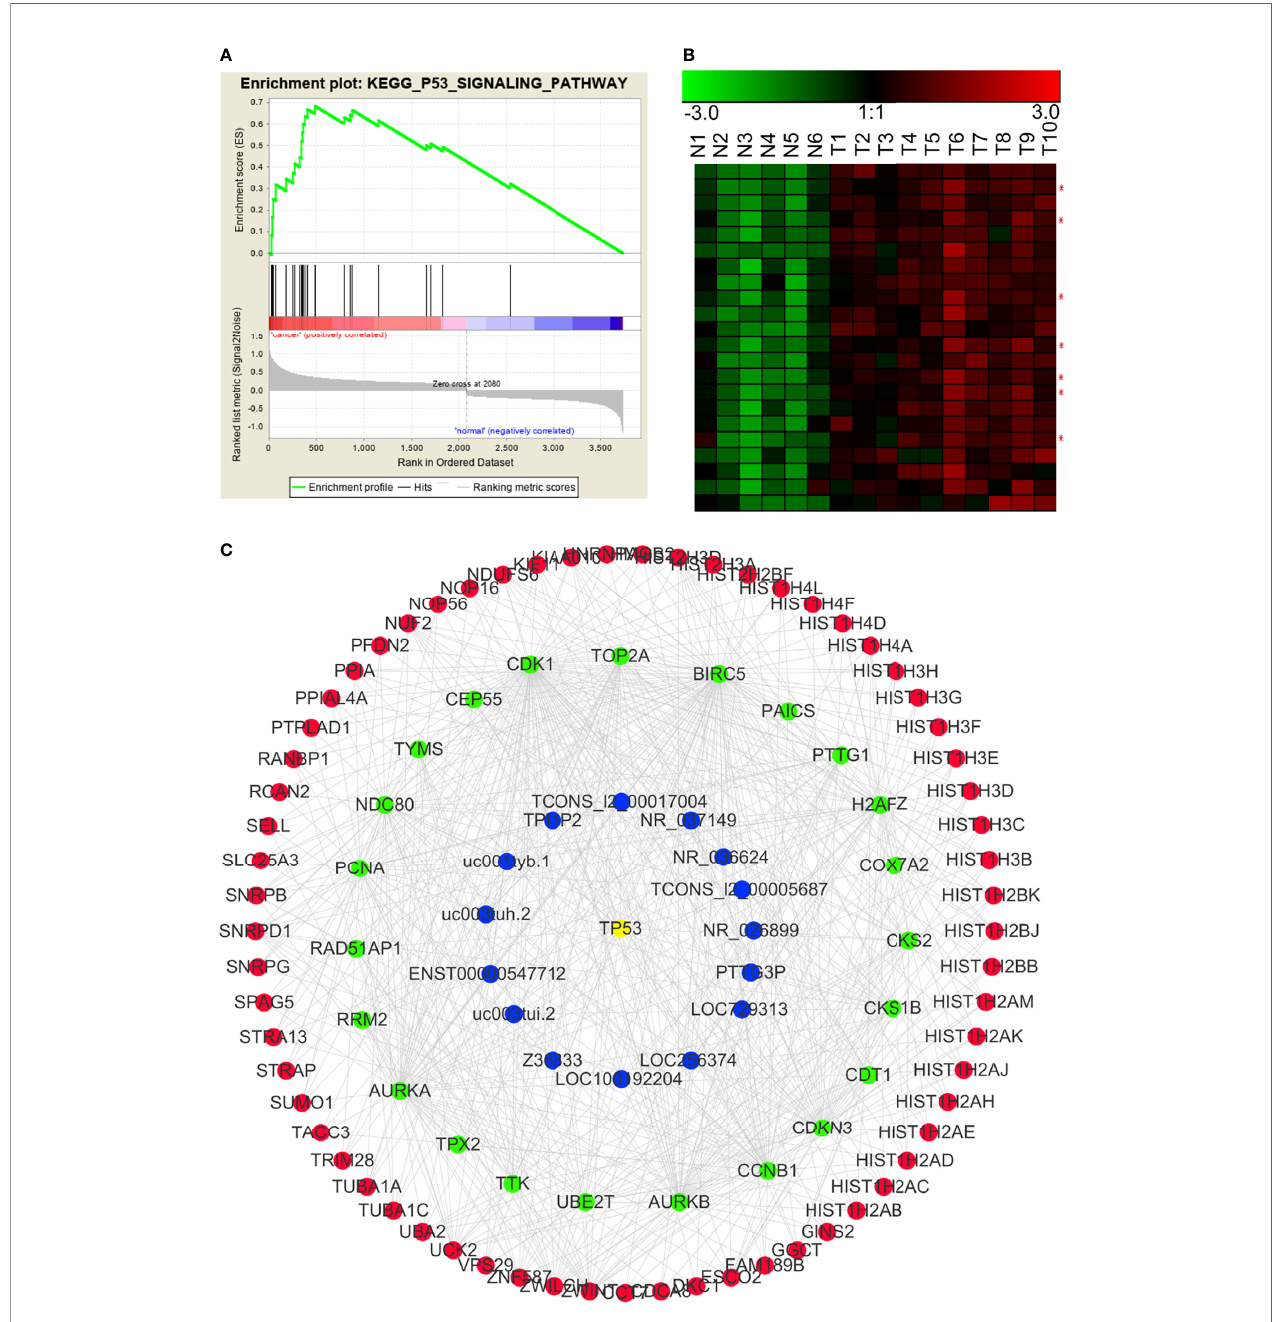
FIGURE 7 | p53 pathway-related lncRNA-mRNA co-expression modules in NPC. (A) GSEA revealed that involvement in the p53 signal pathway was signi fi cantly enriched in the differentially expressed RNAs in NPC. (B) Many genes in the p53 pathway were signi fi cantly up-regulated in NPC (red asterisks indicate lncRNAs). N: the control nasopharyngeal epithelium, T, nasopharyngeal carcinoma. (C) We used GSEA and WGCNA to construct the lncRNA – mRNA co-expression module related to the p53 signaling